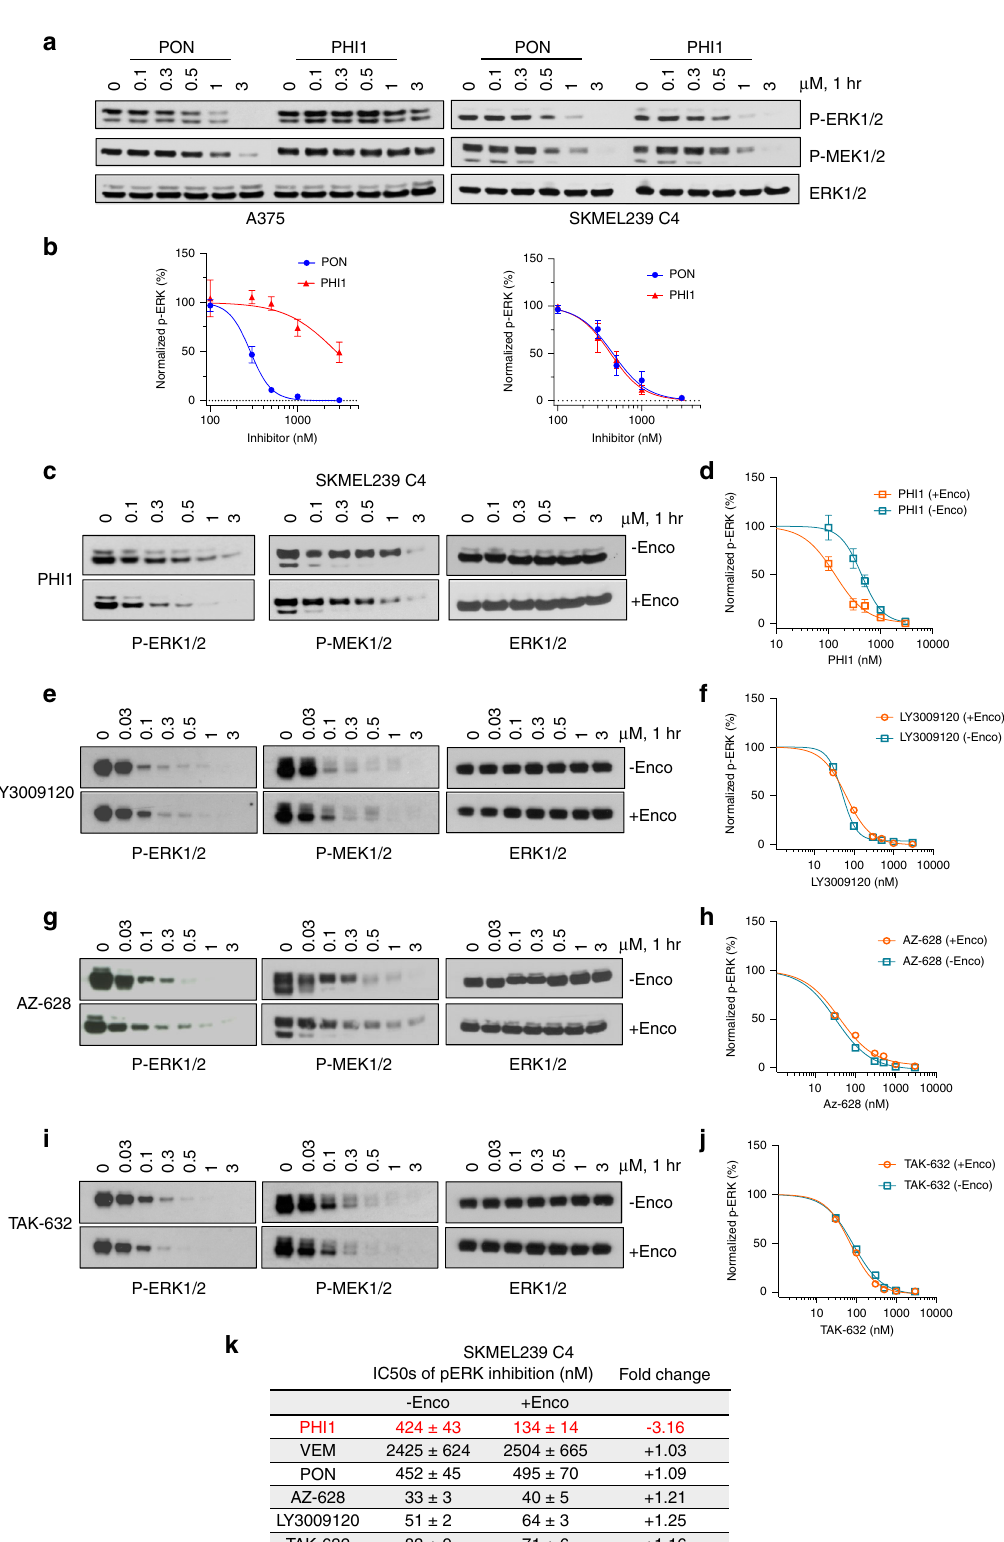
clinical implications and enable repurposing of Ponatinib in melanoma and other oncogenic BRAF-dependent tumors, more likely in a combination therapy with a MEK inhibitor or immunotherapy. The maximum plasma levels (~100 nM) and prolonged elimination half-life (>24 h) of Ponatinib in standard of care dose for CML suggest that Ponatinib would be clinically NATURE COMMUNICATIONS| (2020) 11:4370